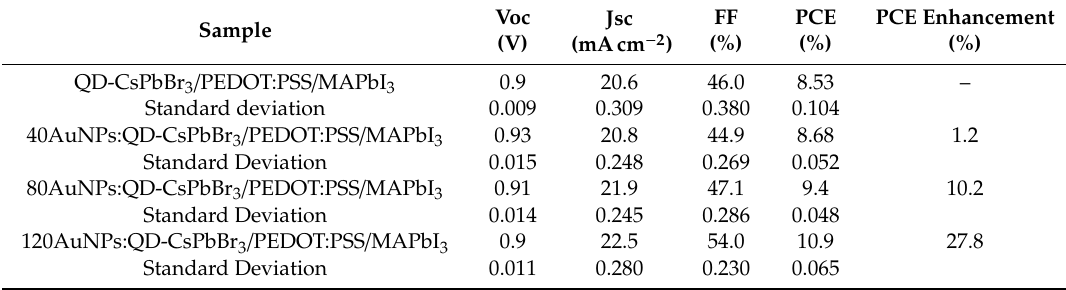
Table 1. Performance parameters of plasmonic perovskite solar cells with and without Au NPs. (Average value with standard deviation from 20